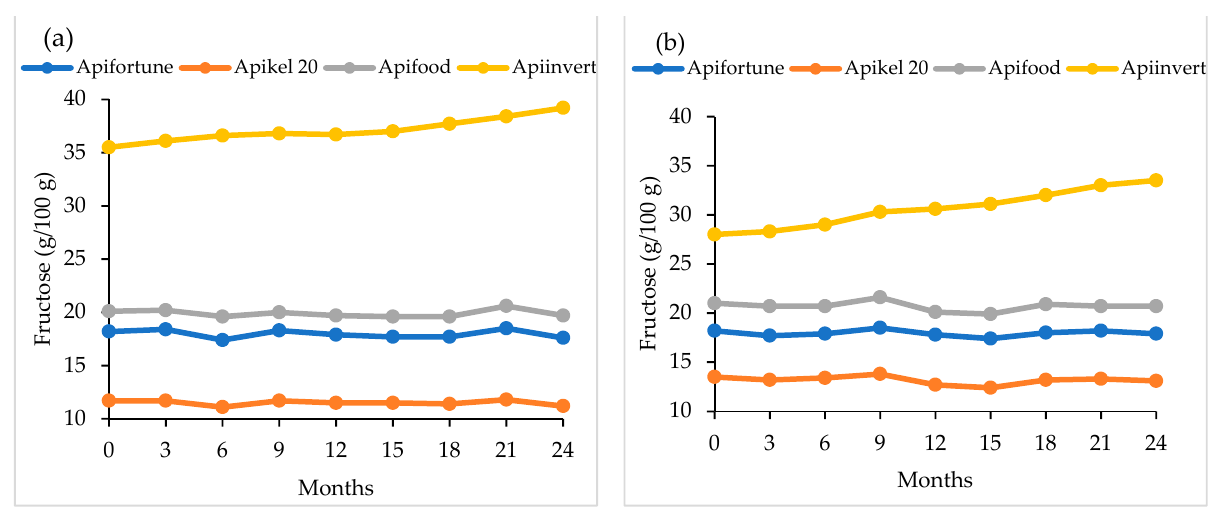
Figure 4. Changes of fructose content in syrups during storage at about 20 °C ( a ) from 2012 and ( b ) from 2013.